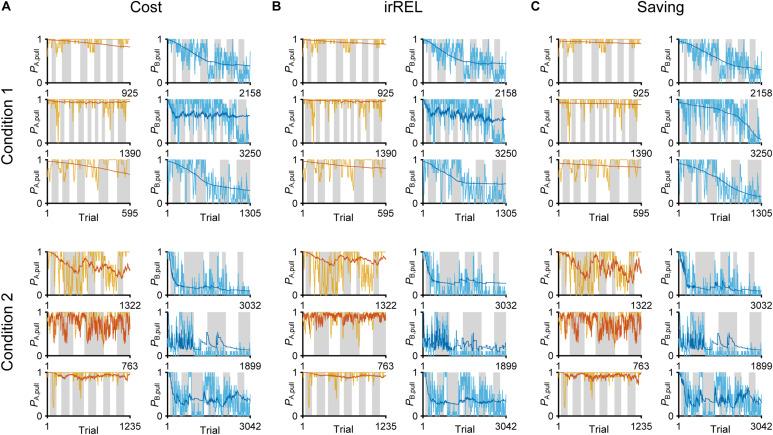
Three Q-learning models to explain the pull-choice probability. Six representative predicted pull-choice probabilities of the models in tone A (left) and B (right) trials in conditions 1 (top three rows) and 2 (bottom three rows). Orange and cyan traces represent the 10-trial moving-average of the actual pull-choice (the same as in Figure 2). Red and blue traces represent the predicted pull-choice probability in cost (A), irREL (B), and saving (C) models.